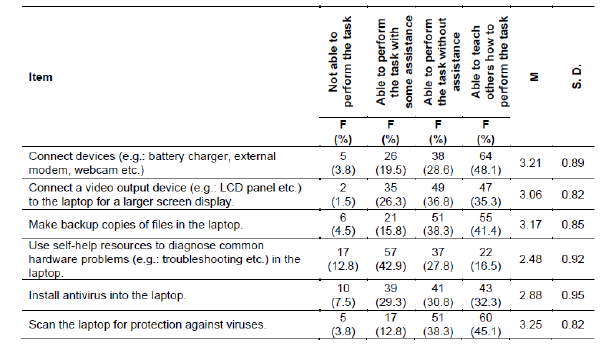
Table 5. Descriptive Statistics for Items on Setup, Maintenance, and Troubleshooting